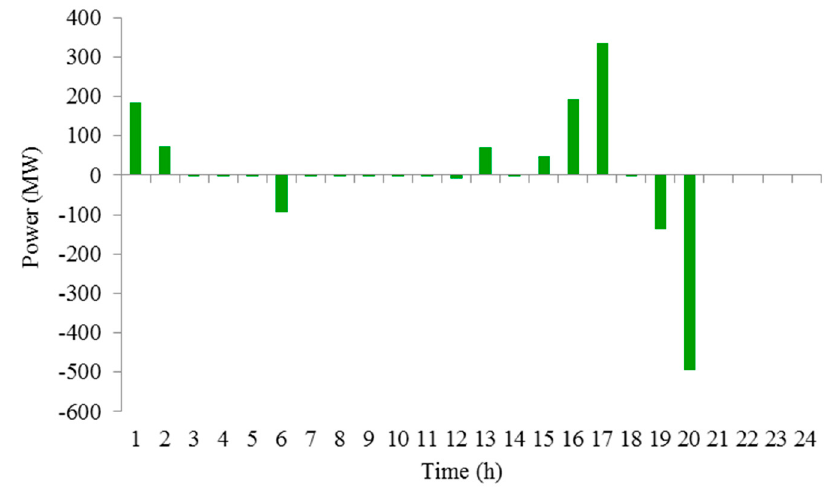
Figure 13. Power output curves of pumped storage generators in Case 1.